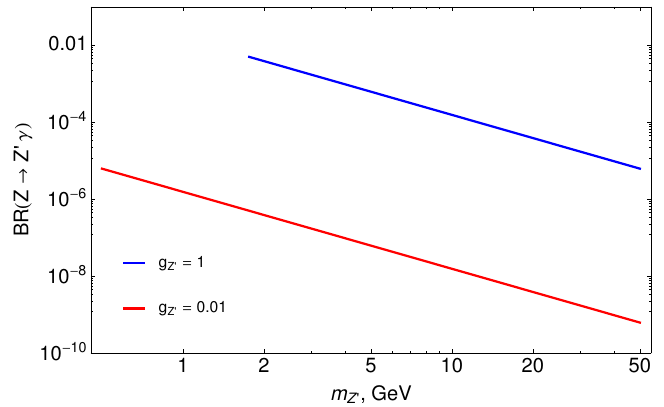
Figure 1 . The exotic BR( Z ! Z 0 (cid:13) ) as a function of the Z 0 mass. We assume g Z 0 = 1 for the blue line and g Z 0 = 0 : 01 for the red line. The anomaly coe(cid:14)cients are chosen to be A Z 0 BB = (cid:0)A Z 0 WW = 1. We assume the cuto(cid:11) of the theory (2.1) to be (cid:3) = 5 TeV and draw the BR line only in the region where the EFT is well